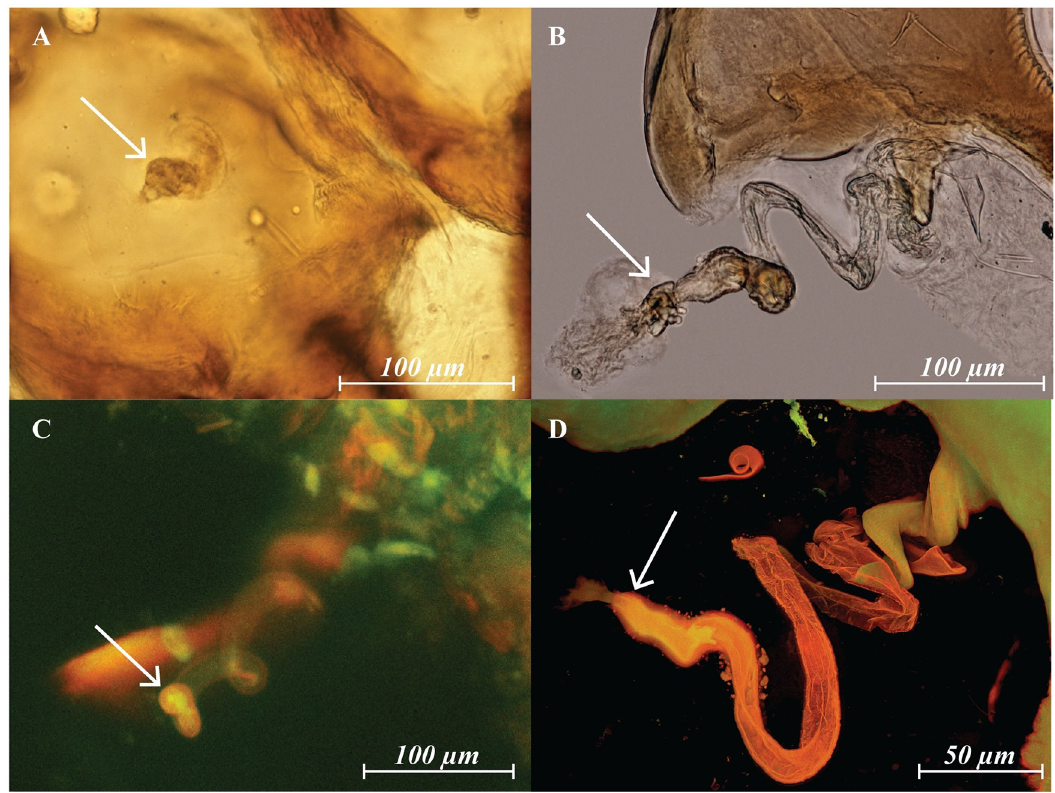
Fig 6. Megalolaelaps colossus female secondary insemination system. (A) DIC Image of cleared specimen, dorsal view (B) DIC image of a dissected specimen (C) MIP images using CLSM of cleared specimen (D) MIP image using CLSM of a dissected